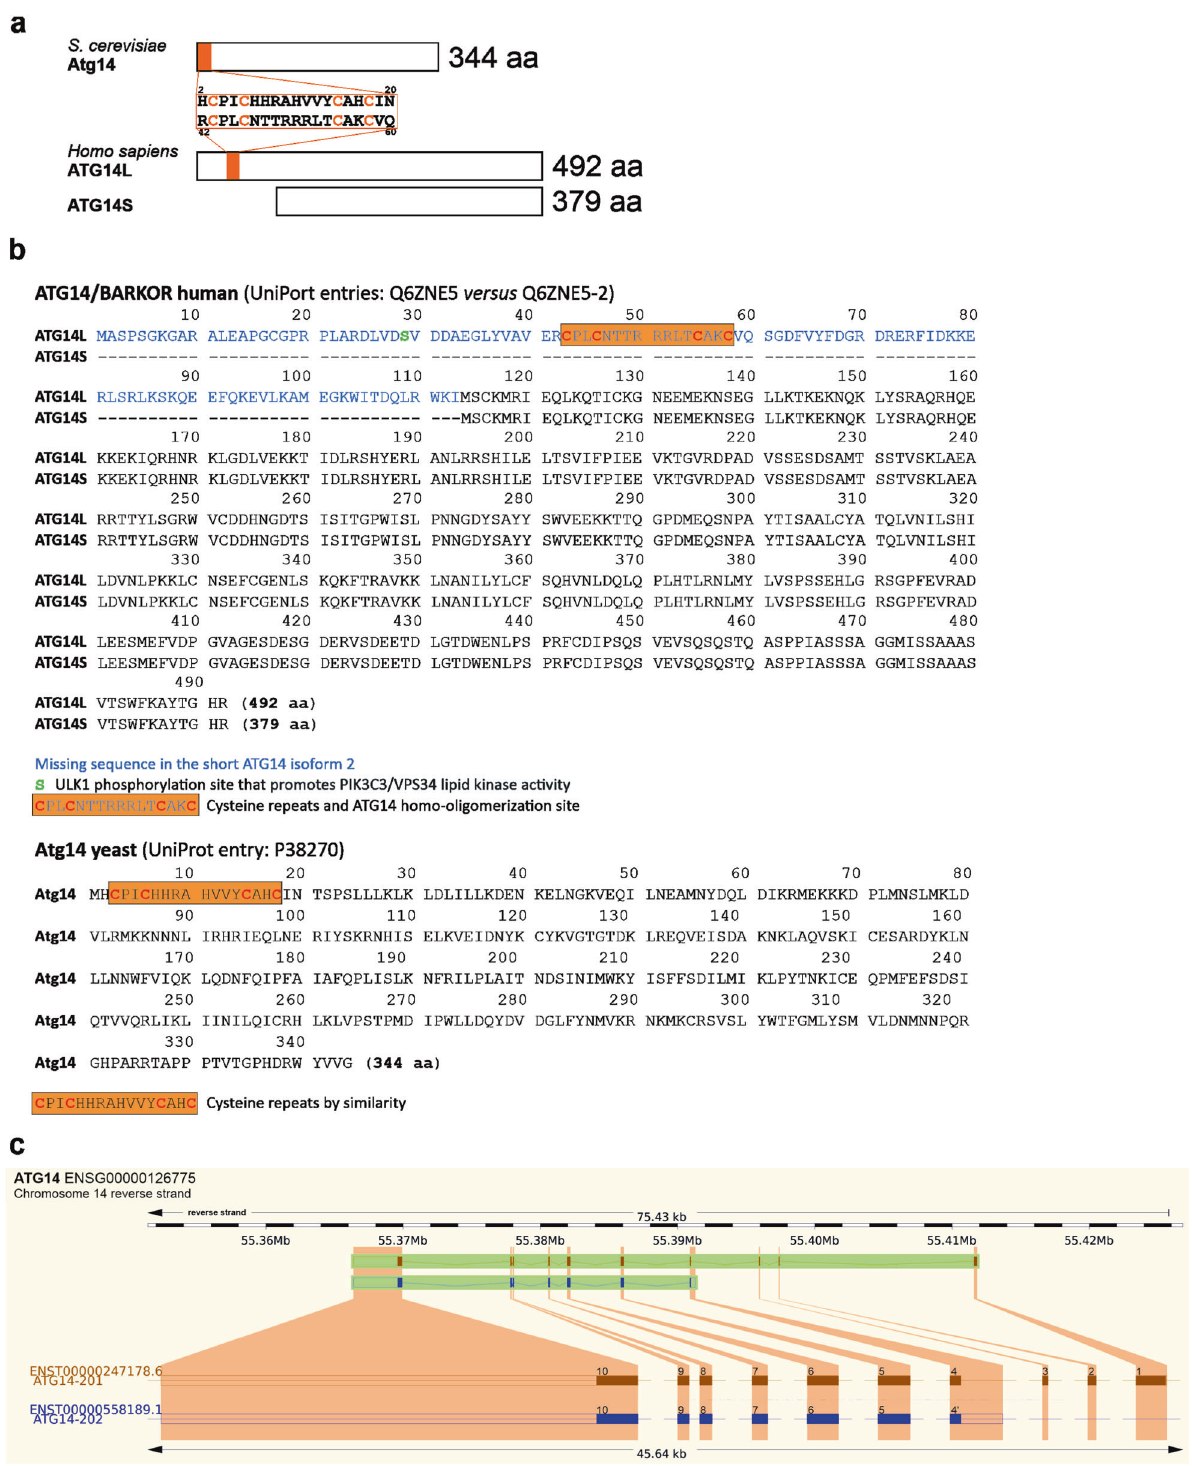
Fig. 5 The yeast Atg14 gene codes for one protein, whereas the human ATG14 gene encodes two protein isoforms. Genome database searches revealed that whereas the yeast Atg14 gene codes for one protein (344 amino acids, aa; UniProt entry: P38270), the human ATG14 gene encodes two isoforms: a long (492 aa) and a short (379 aa) splice isoform, named ATG14L and ATG14S (UniProt entries: Q6ZNE5 and Q6ZNE5-2, respectively). a Schematic illustration of yeast Atg14, human ATG14L and ATG14S proteins with indication of a conserved cysteine repeats domain in the N terminus of yeast Atg14 and human ATG14L involved in ATG14 homo-oligomerization. b Amino acid sequences for yeast Atg14, human ATG14L and ATG14S, with indication of the missing sequence in ATG14S as compared to ATG14L, and location of the cysteine repeats domain in yeast Atg14 and human ATG14L. c Illustration of the structure of the exons and introns present in the ATG14L and ATG14S isoforms based on data extracted from the Ensembl genome browser for the human ATG14 gene.